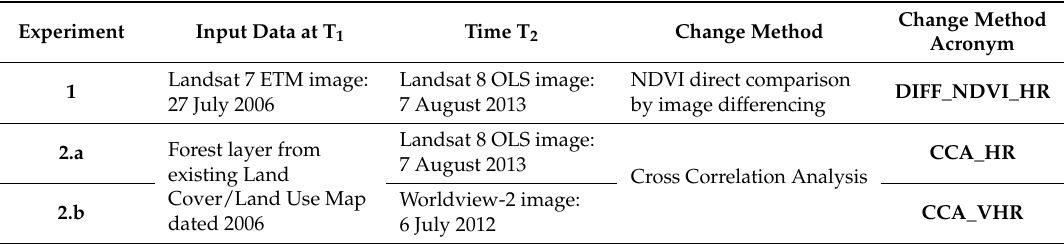
Table 1. Set of experiments and abbreviations used for the Italian site.